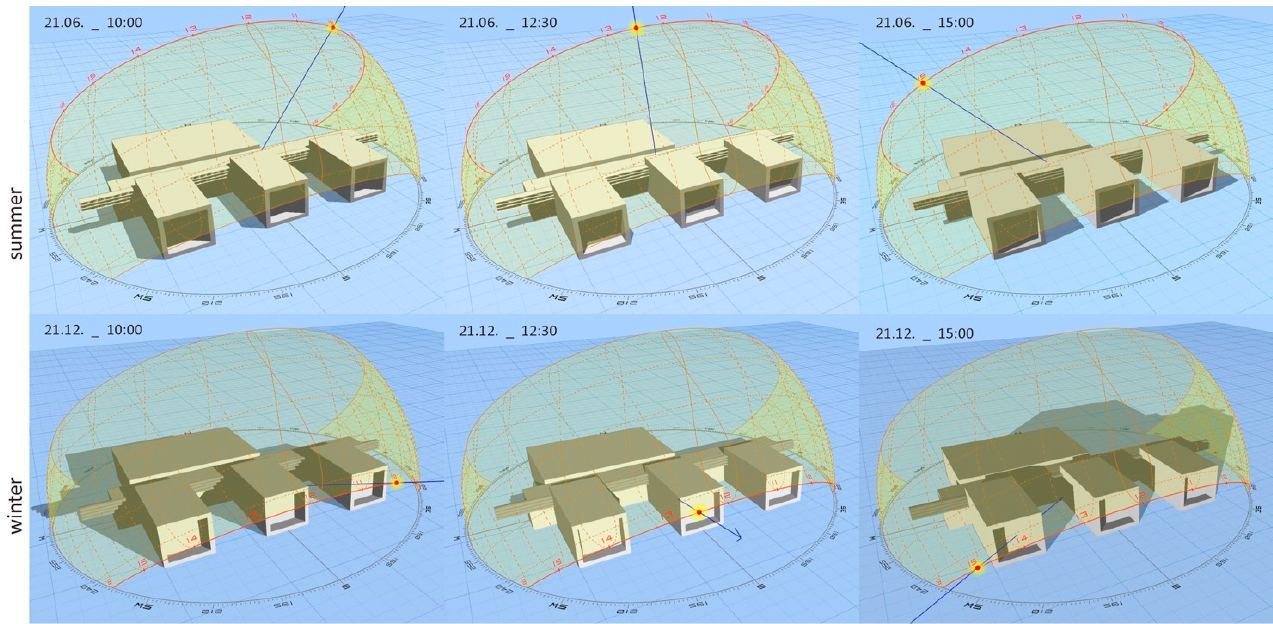
Figure 12. Solar exposure and shading: all glazed surfaces of wellness modules and circulation volume are fully shaded during the summer to prevent overheating ( upper row ) while remaining almost completely exposed during winter ( lower row ), enabling direct passive solar gain.